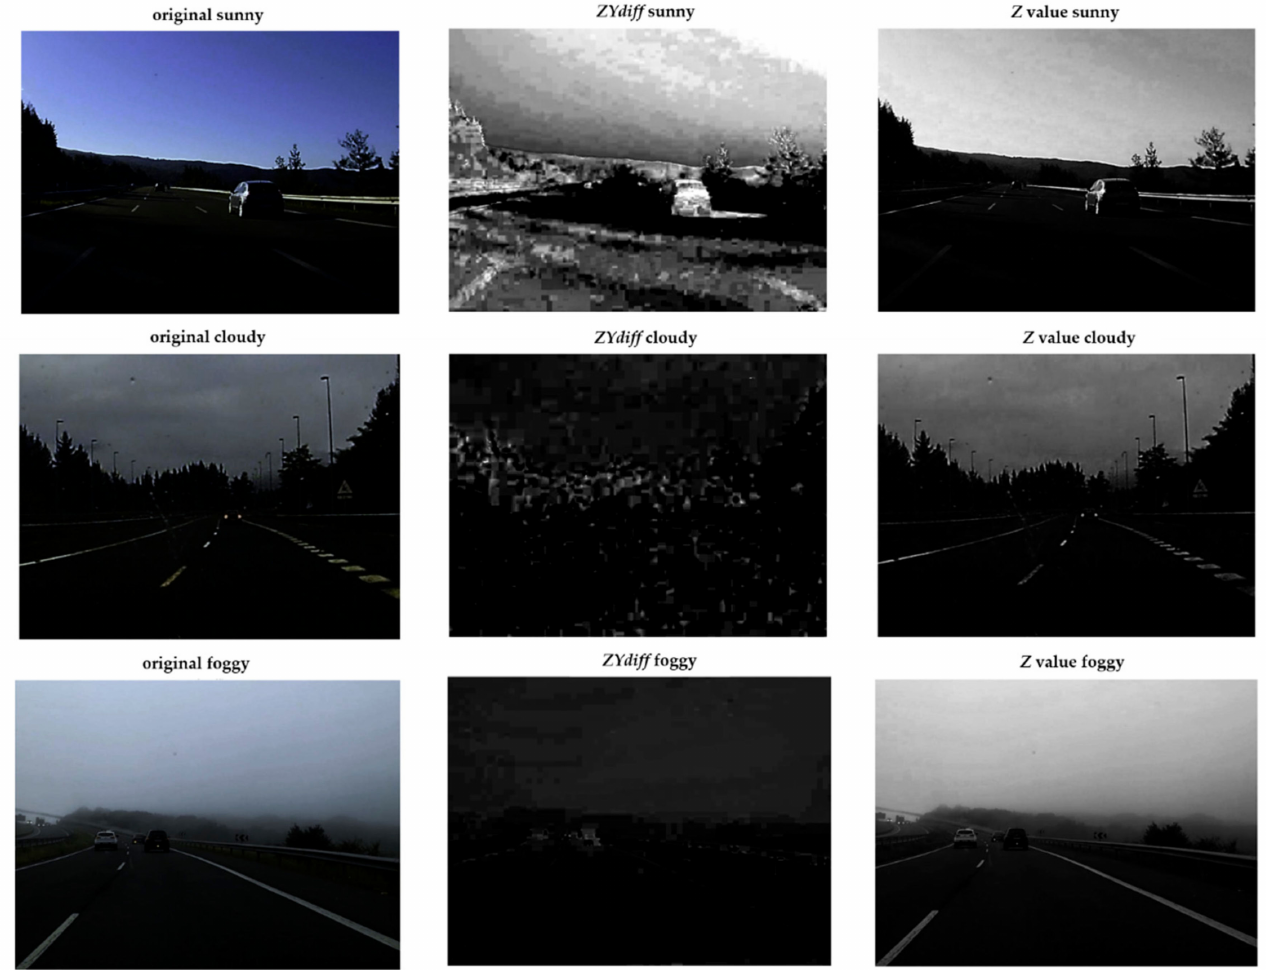
Figure 6. Studied features in three different weather scenes. From up to down—sunny, cloudy and foggy sample